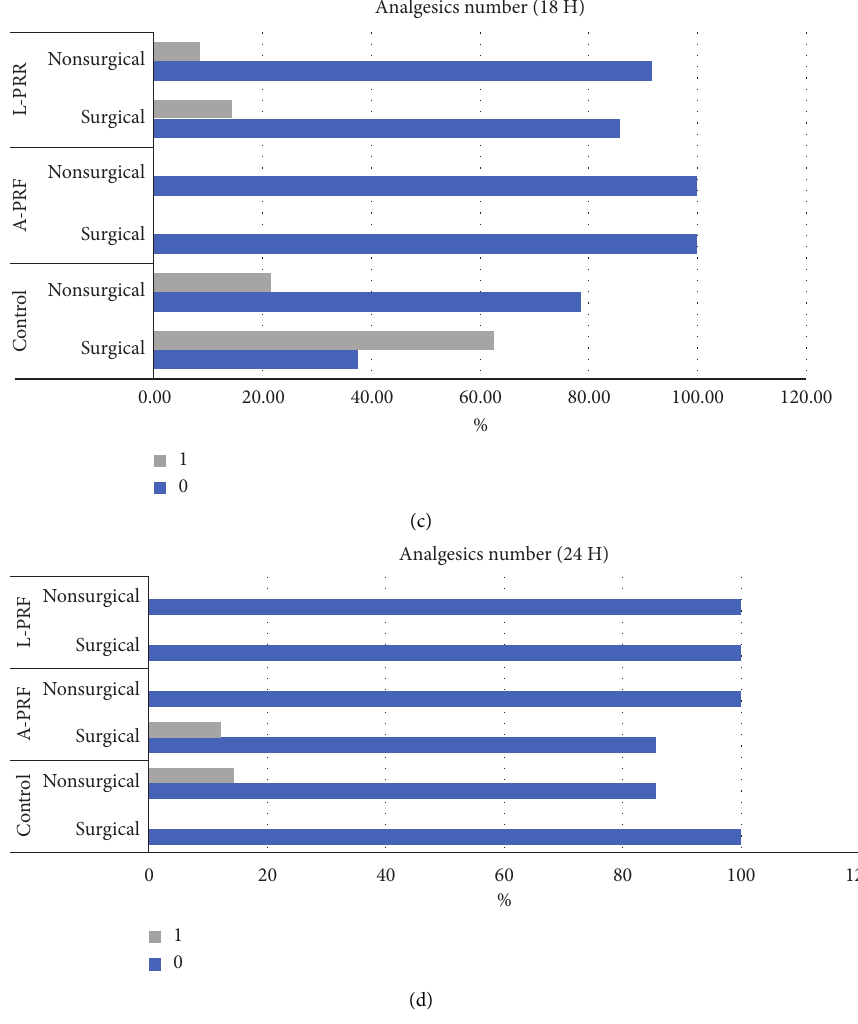
Figure 3: (a) Analgesics number (6 H). A-PRF � advanced platelet-rich fibrin, L-PRF � leukocyte-platelet-rich fibrin. 1 (grey), 0 (blue) represent number of analgesics. (b) Analgesics number (12 H). A-PRF � advanced platelet-rich fibrin, L-PRF � leukocyte-platelet-rich fibrin. 1 (grey), 0 (blue), 2 (light blue) represent number of analgesics. (c) A-PRF � advanced platelet-rich fibrin, L-PRF � leukocyte-platelet-rich fibrin. Analgesics number (18 H). 1 (grey), 0 (blue) represent number of analgesics. (d). Analgesics number (24 H). A-PRF � advanced platelet-rich fibrin, L-PRF � leukocyte-platelet-rich fibrin. 1 (grey), 0 (blue), 2 (light blue) represent number of analgesics.